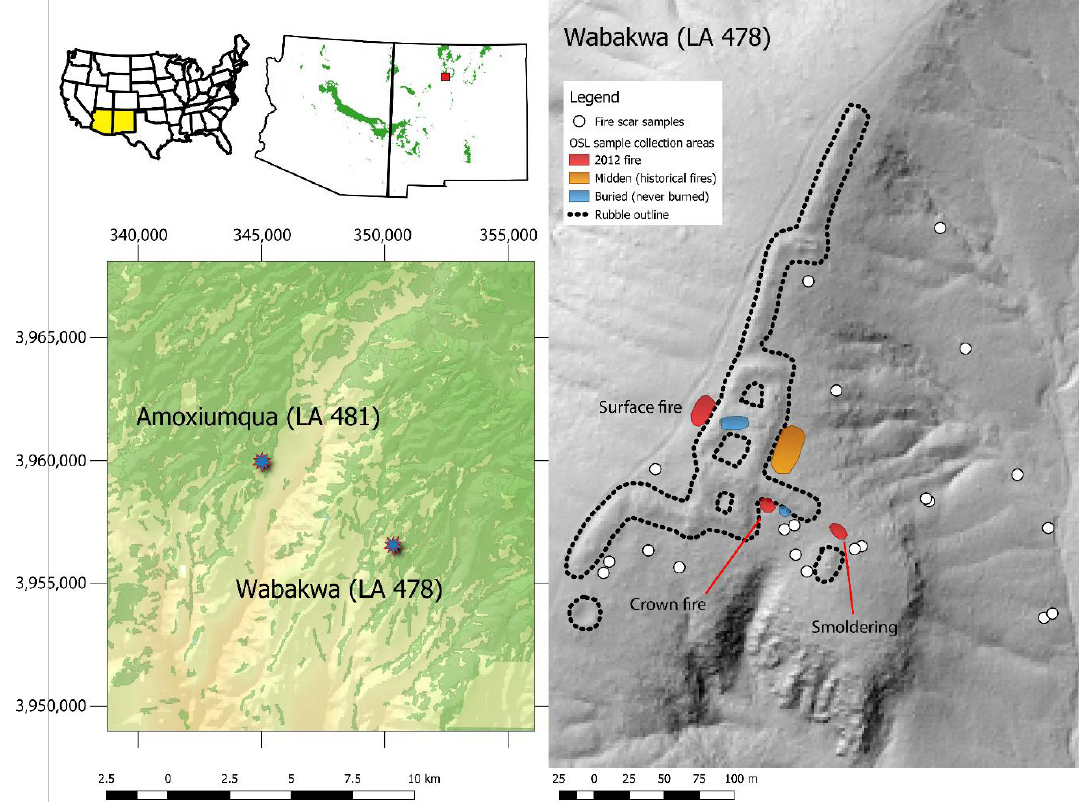
Figure 1. The geographic location of the archaeological site of Wabakwa. ( a , b ) The location of the study area in northern New Mexico (red square) in the Southwest USA. Green areas are the locations of ponderosa pine forests in ( b ). ( c ) The study site of Wabakwa (LA 478) and the reference site of Amoxiumqua (LA 481) are situated within the distribution of ponderosa pine forests (dark green). Tick marks record the geographic location in Northing and Easting (m) for UTM zone 13N. ( d ) The ceramic collection areas for optically stimulated luminescence (OSL) dating are plotted relative to the topography of the ruin and the fire scar collection locations.